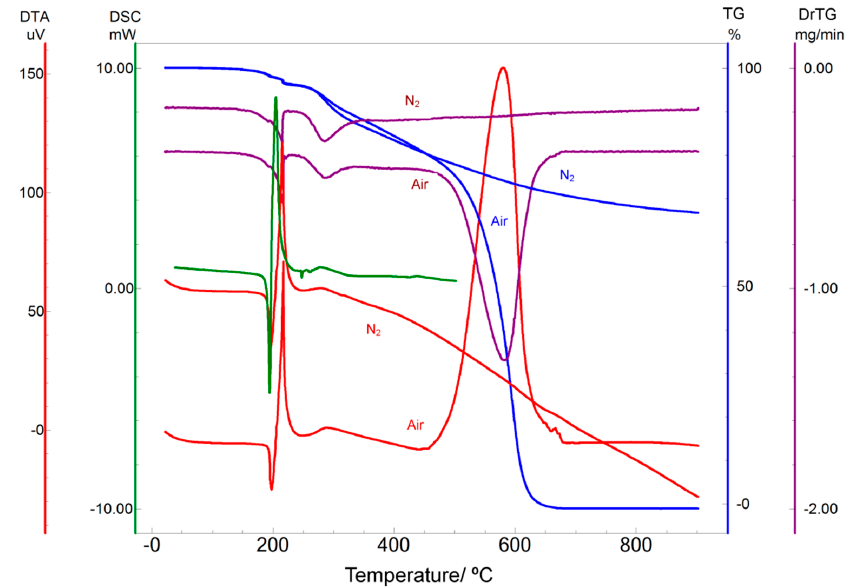
Figure 2. Differential scanning calorimetry (DSC), thermogravimetry TG/DrTG and differential thermal analysis (DTA) curves for IVS320 obtained at a heating rate of 10 °C·min − 1 in a dynamic